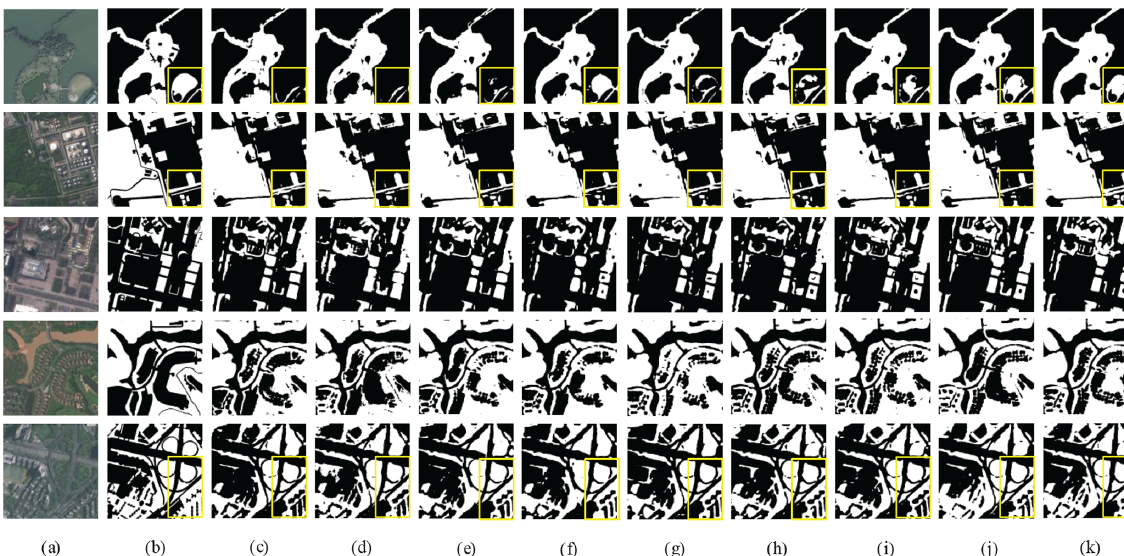
Figure 17. Visualization comparisons of different methods in UGSet Images are from © Gaofen-2 2019. (a) Image. (b) Label. (c) SegNet. (d) U-Net. (e) UPerNet. (f) BiSeNet. (g) PSPNet. (h) Base. (i) Base+ECA. (j) Base+point head. (k)